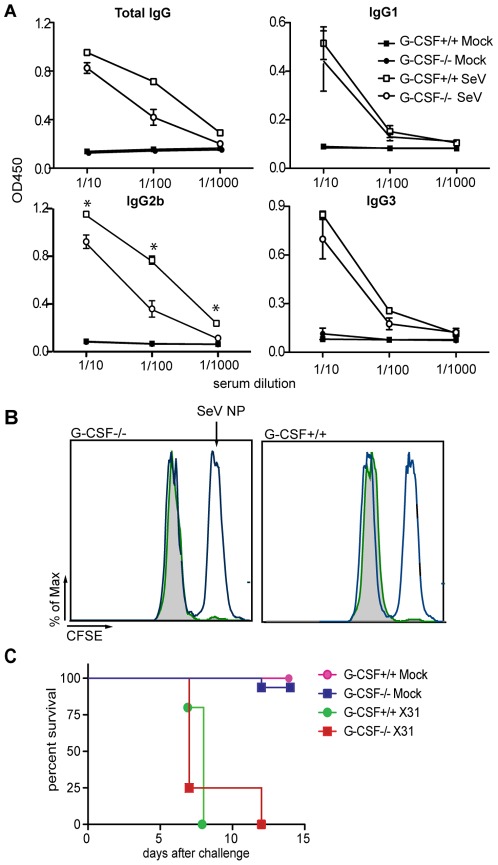
Adaptive immunity in the absence of G-CSF.(A) SeV specific antibodies in lung homogenate of G-CSF+/+ and G-CSF−/− mice measured by ELISA 7 days after infection (n = 4). Experiment shown is representative of two independent experiments. IgG2a p>0.15, IgG3 p>0.07, IgG2b p<0.006, total IgG p<0.03 between infected G-CSF+/+ and infected G-CSF−/− for all dilutions. (B) Mock and SeV infected G-CSF+/+ or G-CSF−/− mice were injected i.v. 7 days after infection with CFSE-labeled peptide-pulsed splenocytes. Splenocytes labeled with a high dose of CFSE were pulsed with SeV NP peptide and those labeled with a low dose of CFSE were pulsed with the irrelevant influenza virus (PR8) NP peptide. Empty histograms show CFSE staining on mock-infected animals 24 h after injection of labeled/pulsed splenocytes. Filled histograms correspond to CFSE staining on SeV infected mice 24 h after injection of labeled/pulsed splenocytes (n = 4 per group). Experiment shown is representative of two independent experiments. (C) Survival of G-CSF+/+ and G-CSF−/− mice infected with a sublethal dose of influenza virus ×31 or mock treated and challenged at day 19 with a normally lethal dose of influenza virus PR8. Survival was monitored daily (n = 14/16 mice in ×31 challenged groups, n = 5 in mock treated controls). Experiment shown is representative of two independent experiments.